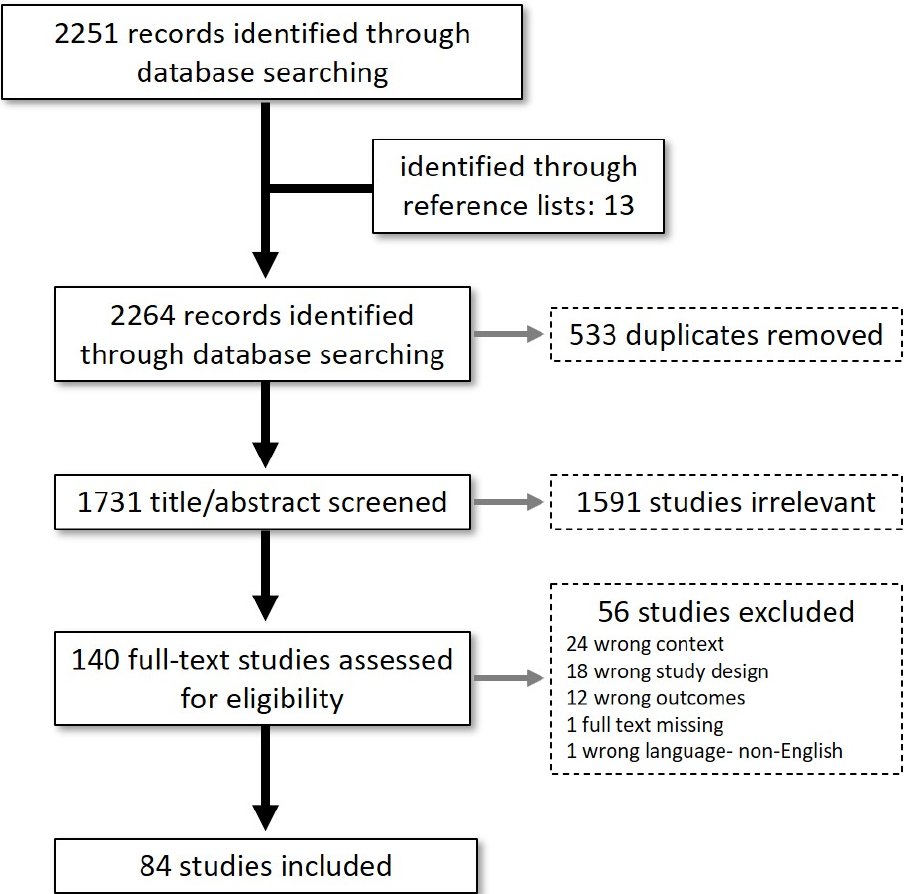
Figure 1. Study Selection Process. Two reviewers performed title/abstract and full-text screening. “Wrong” is used to indicate study characteristics (context, study design, or outcomes), which did not match our inclusion criteria. These unmet criteria were not apparent during abstract screening although were evident upon full text